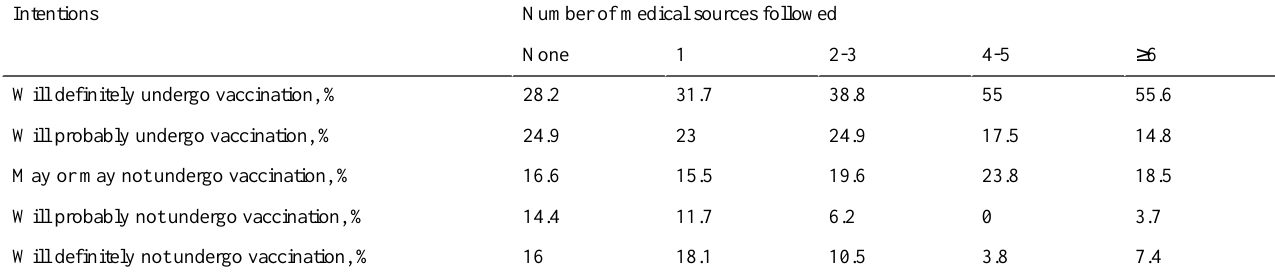
Number of medical sources